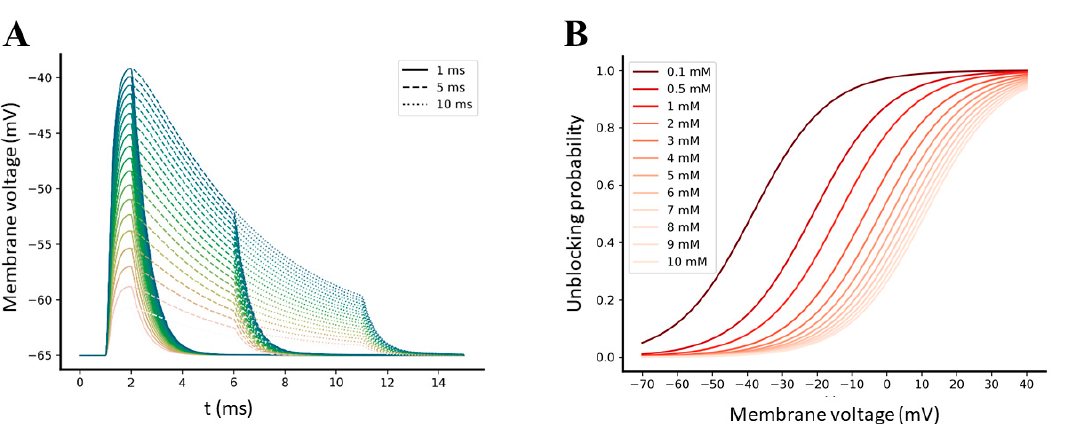
Figure 6. ( A ) Simulated AMPA-mediated EPSPs evoked by different numbers of available AMPA receptors, ranging from 20 (lower trace) to 200 (upper trace). Solid, dashed, and dotted traces refer to single pulse stimulation performed with a glutamate pulse width of, respectively, 1, 5, and 10 ms. ( B ) Sigmoidal unblocking probability function for Mg 2+ block, expressed as a function of membrane voltage. Each trace corresponds to a different value of extracellular Mg 2+ concentra- tion.